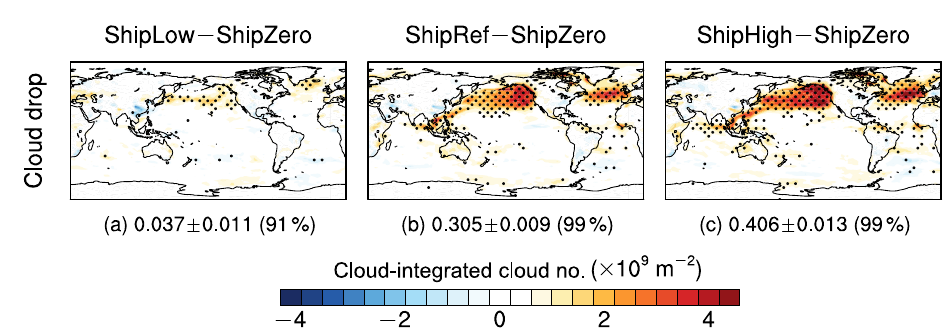
Figure 5. Spatial patterns of MARC-simulated column-integrated cloud droplet number concentration ( × 10 9 m − 2 ) response to international shipping emissions. The responses are calculated as the differences of cloud droplet number integrated through the whole atmospheric column between the simulation without shipping emissions and three simulations with the reference shipping emissions and various DMS emissions (i.e., zero, low, and reference) over the 30-year simulation period. The numbers below each panel are the global means, standard deviation across the 30-year period, and the confidence level. The black dots represent grid points that are statistically significant above the 90% confidence level based on the two-tailed Student’s t